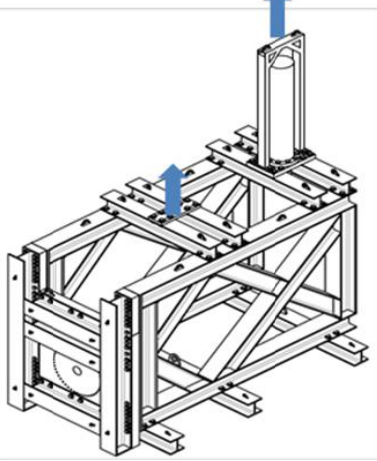
Fig.10. Schematic drawing of test frame